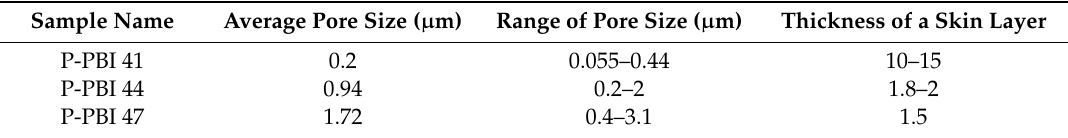
Table 2. Summary of the structural properties of the P-PBI membranes.